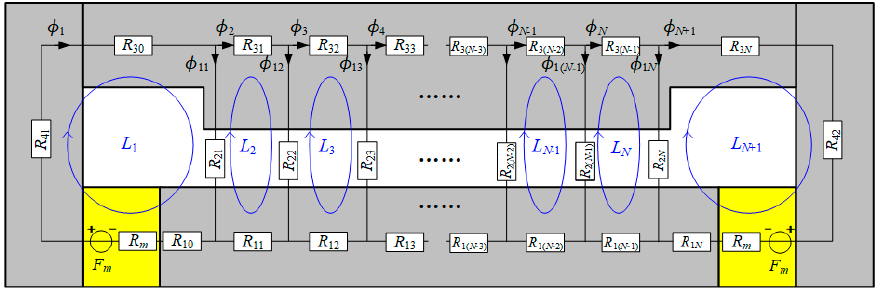
Figure 2. Lumped parameter magnetic equivalent circuit (LPMEC) model of the RCDMC.